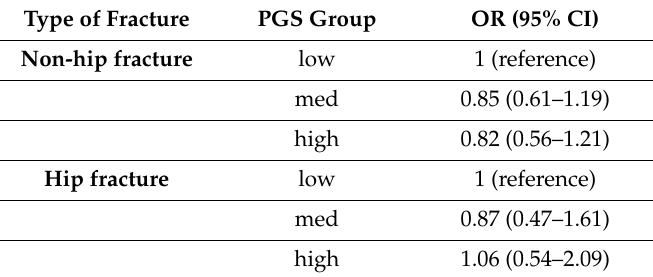
Table A1. Odds ratios (OR) with 95% Confidence Interval (CI) for Outcomes of Incidence Fracture According to PGS Groups, adjusted for T-score diagnosis: Results from Multinomial Logistic Regression.